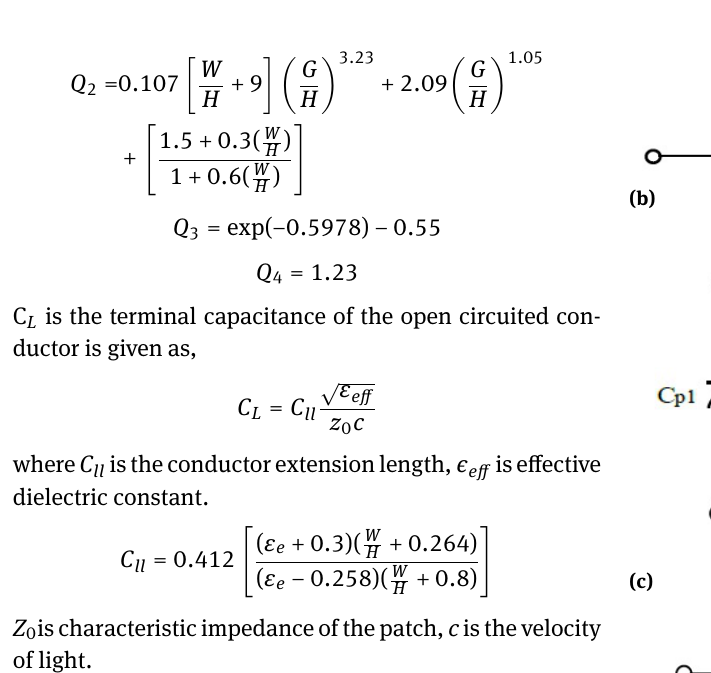
Figure 2: Current distribution (a) Lower and (b) higher resonance frequency.